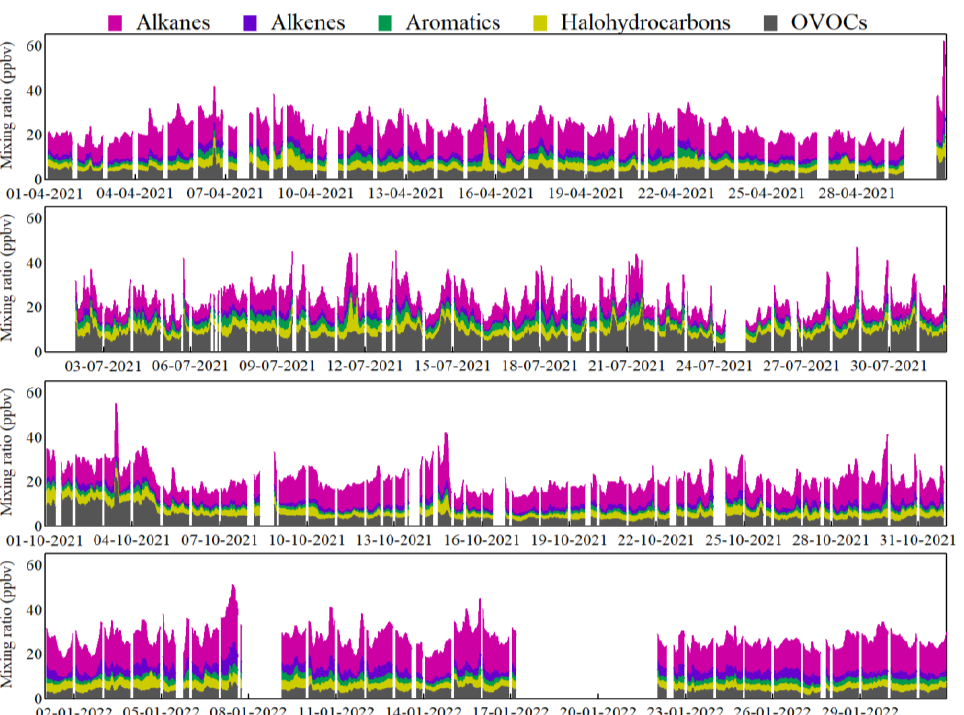
Figure 2. Time serials of observed VOCs during four periods.